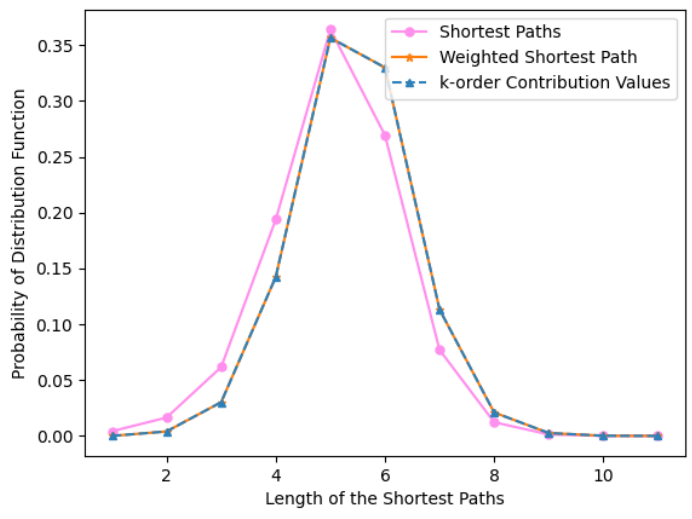
Figure 4. The distribution of weighted shortest path and the k-order contribution value in the Erd˝os–Rényi network with 1000 nodes and the connection probability of 0.004.